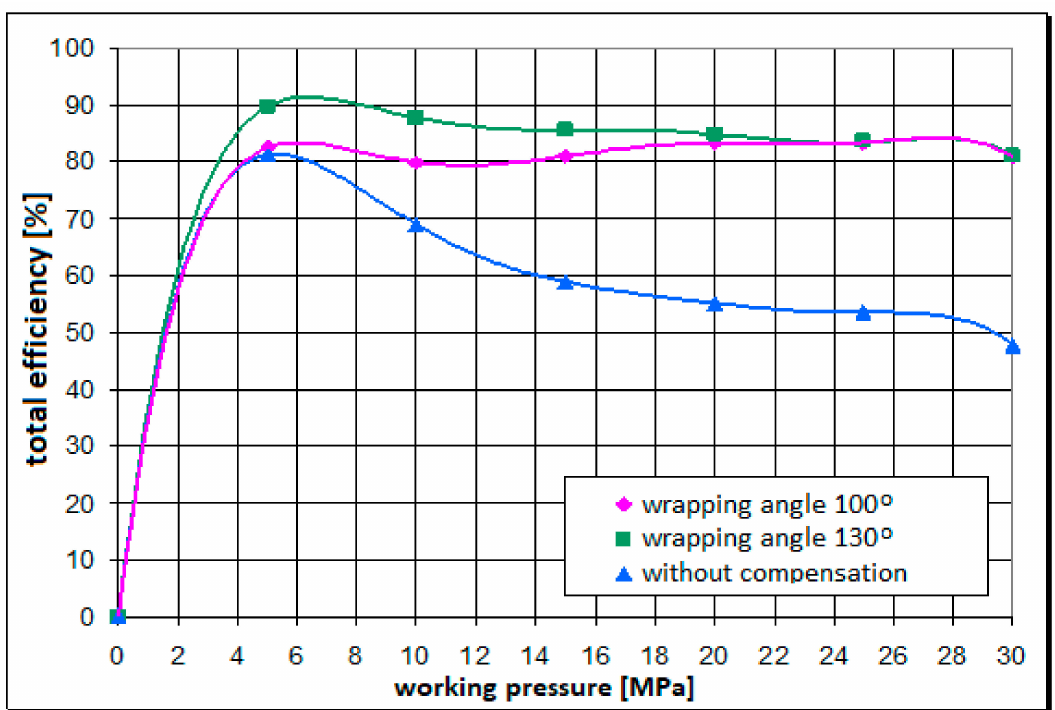
Figure 3. Total efficiency for the conventional pump and for the prototype pumps with circumferential backlash compensa- tion having the wrapping angles ϕ o = 100 ◦ and 130 ◦ , with n = 500 rev/min.